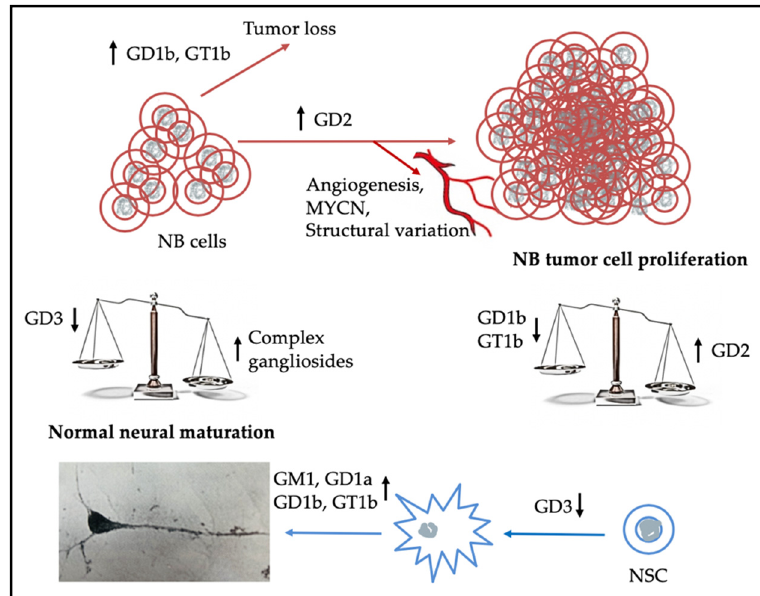
Figure 2. Elevated expression of GD2 and below average expression of b-series gangliosides by NB cells results in cell proliferation giving rise to a tumor that may be refractory to treatment, while children with NBs that express higher concentrations of the more complex b-series gangliosides tend to have a better outcome [19,20]. Unanswered is what is the mechanism for clearance of tumor cells in children whose tumors express more of the b-series gangliosides and regress spontaneously. The lower half of the schematic indicates that as expression of GD3 by neural stem cells (NSCs) decreases and that of the more complex gangliosides increases, they start to differentiate and to express a ganglioside pattern associated with mature neurons [69].